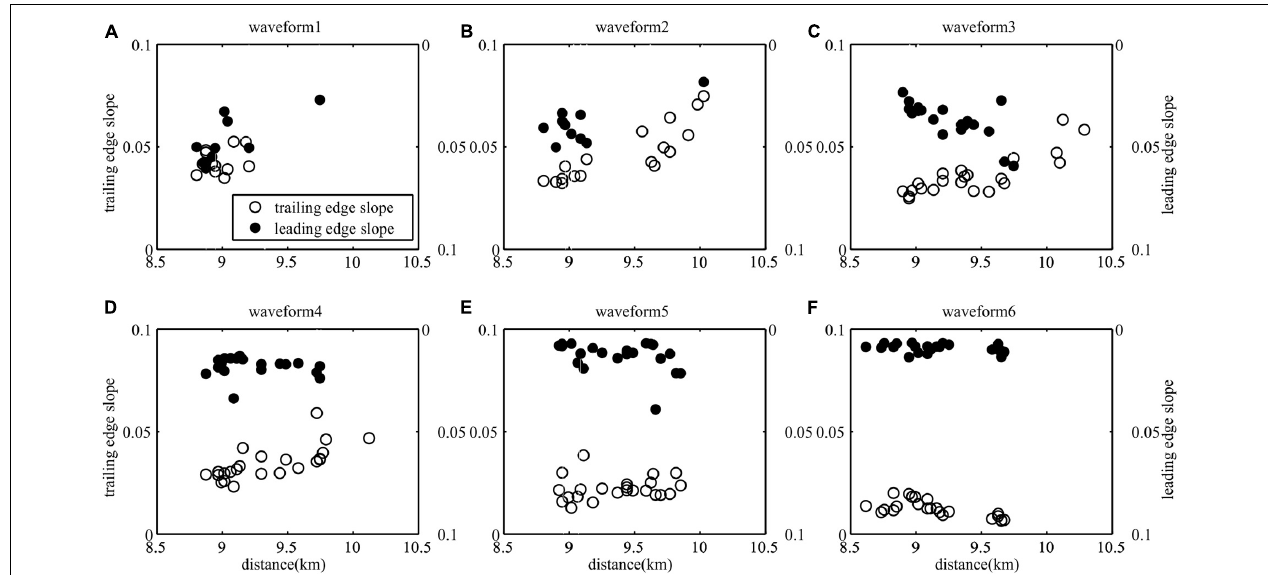
FIGURE 10 | The changes in the slope of the leading and trailing edge of the six waveforms. (A–F) The solid black dots represent the slope of the leading edge and the slope magnitude is shown in the right-hand side. The open dots represent the slope of the trailing edge and the slope magnitude is shown in the left-hand